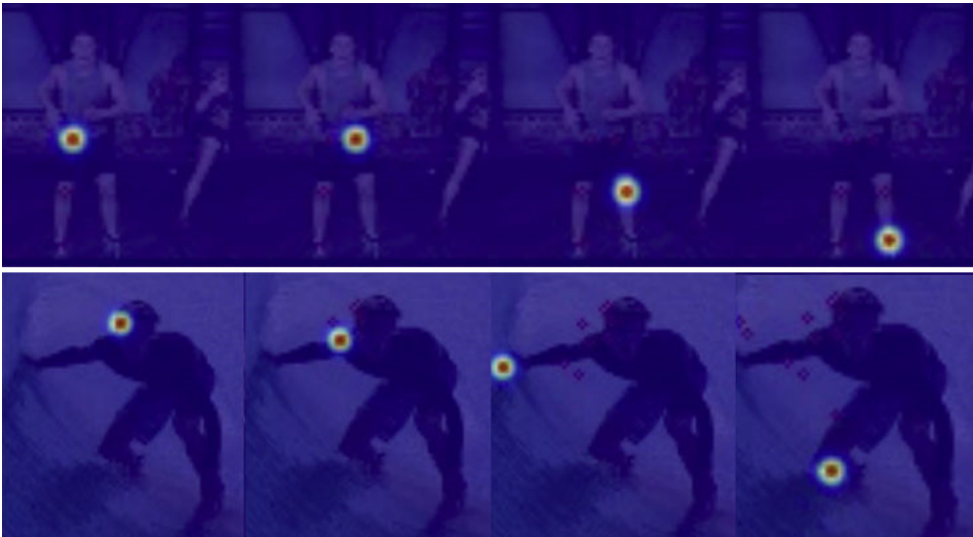
Figure 3. Visualization of Cofopose’s process of decoding for the keypoint detection transformer on MPII and COCO is denoted by the first and second rows, respectively. For MPII, the first, second, third, and fourth columns represent the right hip, left hip, left knee, and left ankle, respectively. For COCO, the first, second, third, and fourth columns represent right eye, right shoulder, right wrist, and right knee, respectively.